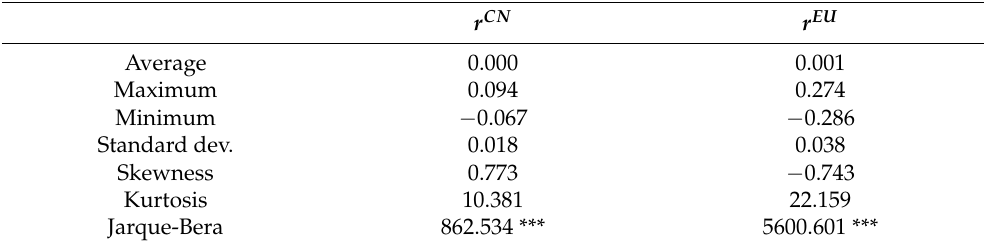
Table 1. Summary